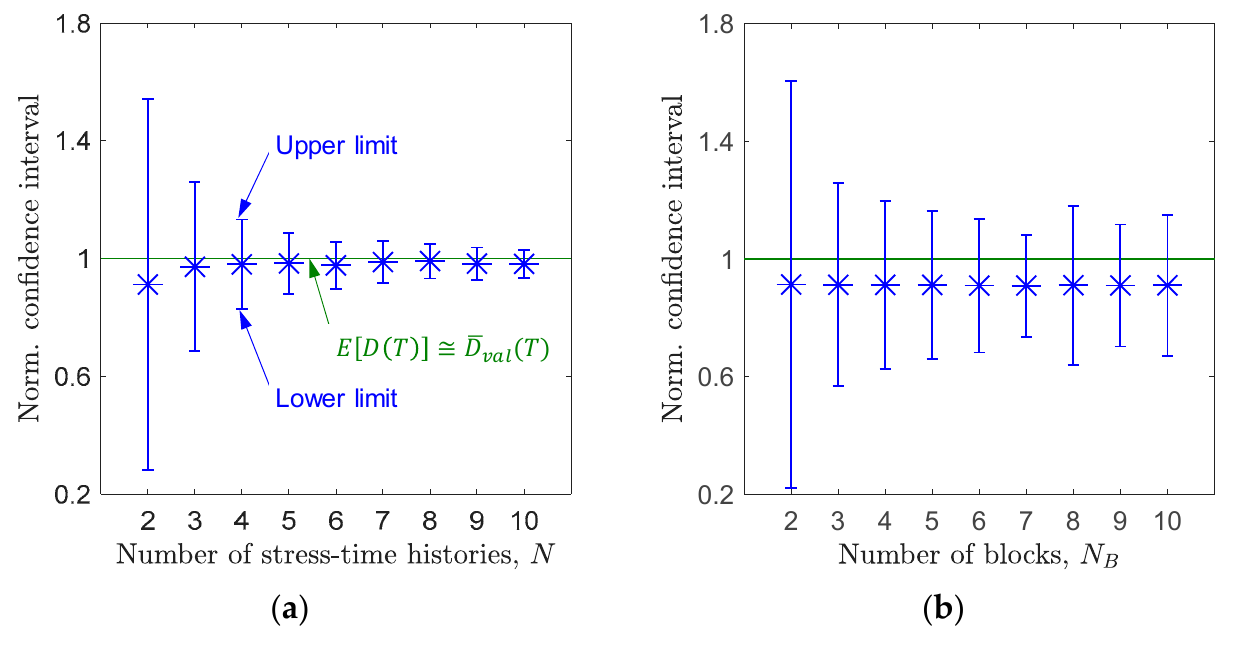
Figure 11. Confidence intervals for measured stationary stress-time histories as a function of ( a ) number of records (Case M) and ( b ) number of subdividing blocks (Case S).